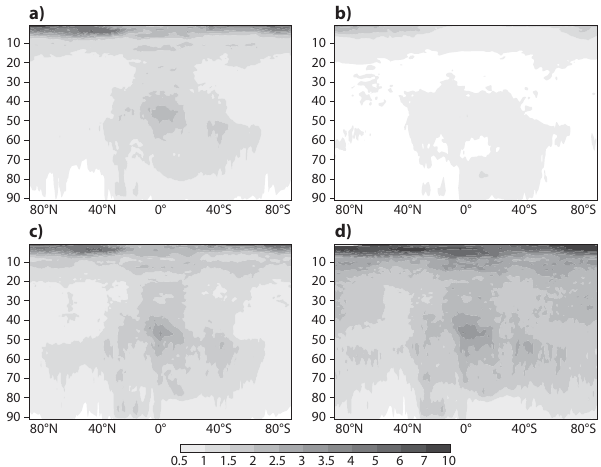
Figure 3. Zonally averaged cross section for the period 5 October to 15 November 2008 for the u component of the EDA spread. (a) OBS-EDA , (b) OBS-OBS-EDA , (c) ST-EDA and (d) XB-EDA . The vertical coordinate is model level. Contours are in ms − 1 .